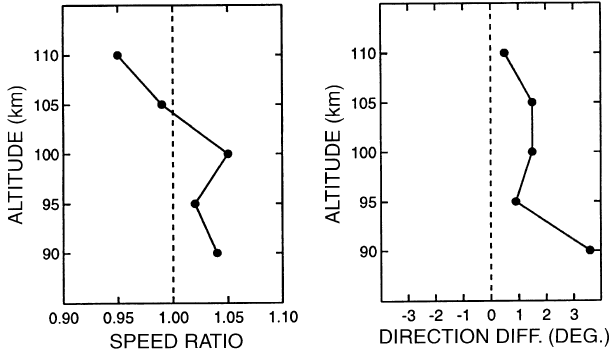
Fig. 8. Mean WINDII/HRDI wind-speed ratios ( left-hand panel ) and direction di(cid:128)erences ( right-hand panel ) as a function of altitude obtained with the histogram method